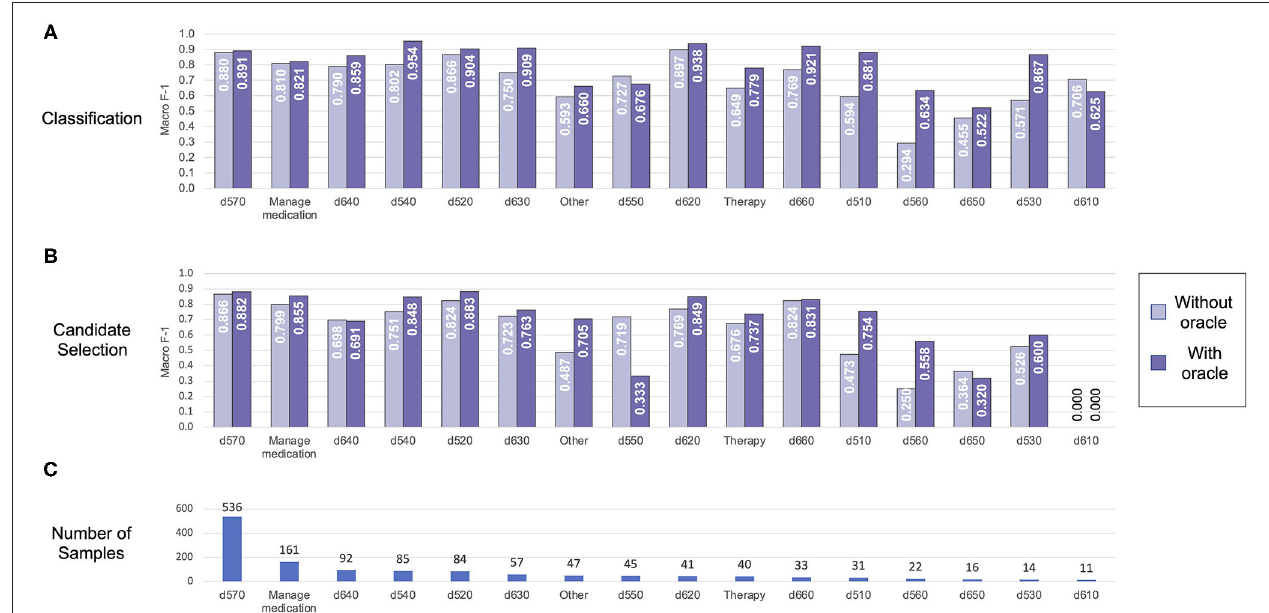
FIGURE 7 | Automated coding performance for each distinct category in the Self-Care/Domestic Life dataset. Classification results are shown in (A) , and candidate selection results in (B) . Categories are ordered by descending frequency [illustrated in (C)